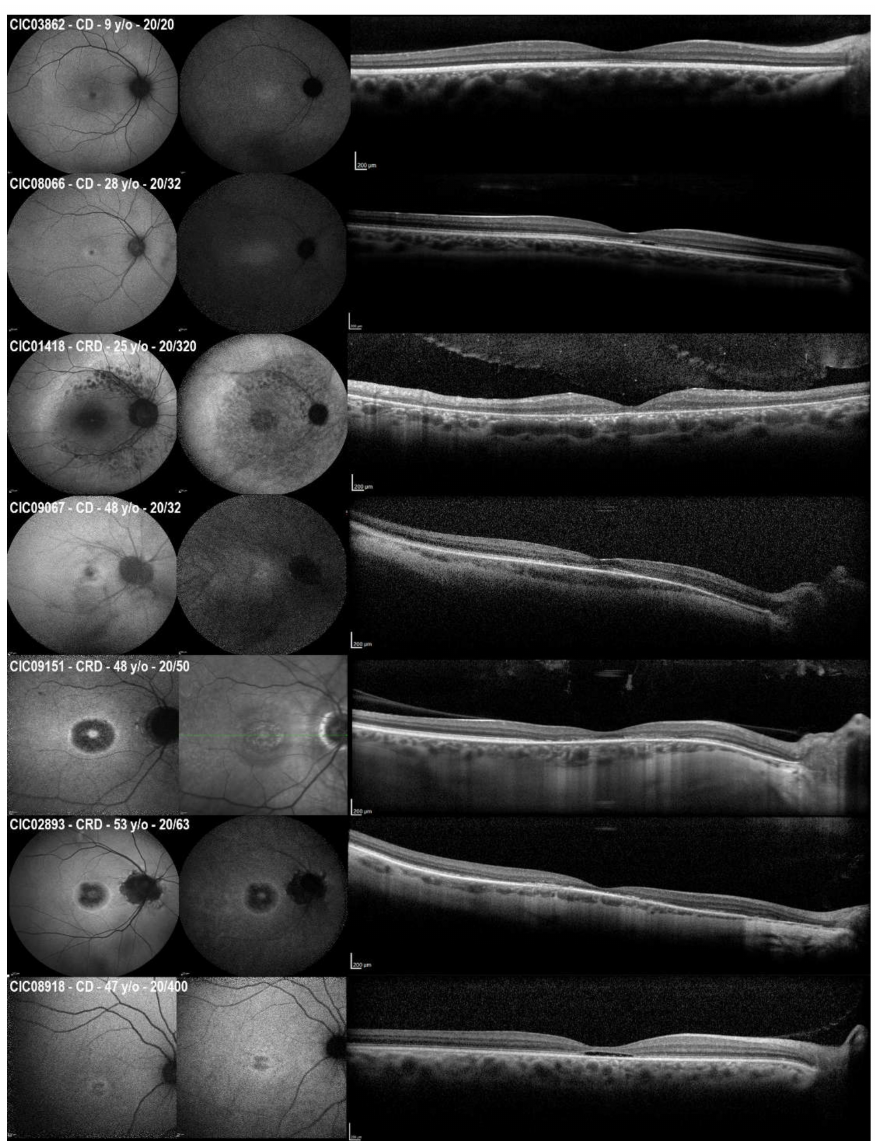
Figure 2. The short-wavelength fundus autofluorescence (SW-FAF, left ), near-infrared fundus aut- ofluorescence (NIR-FAF, middle), and optical coherence tomography (OCT, right ) of six patients with CD/CRD included in the study. For CIC09151, the NIR-FAF was not available and was replaced with a near-infrared reflectance image. Phenotypes may range from the focal central alterations (e.g., in CIC03862 CIC08066, CIC09067, CIC08918) to a progressively more extended disease (e.g., CIC09151, CIC02893, and CIC01418). Patients with similar ages may show different degrees of retinal degenera- tions. CIC09067 and CIC09151 are affected brothers that showed different phenotypes (CD and CRD, respectively) with different retinal involvement, despite sharing the same RPGR ORF15 pathogenic variant and having the same age at the time of